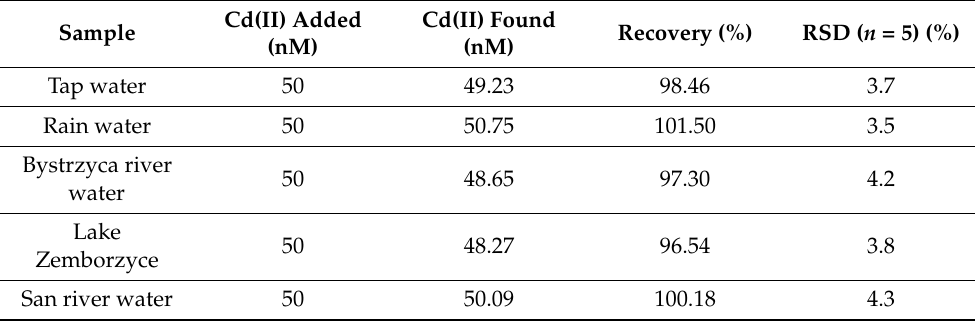
Table 5. Analytical results of Cd(II) determination in natural water samples. The samples were examined using the standard addition